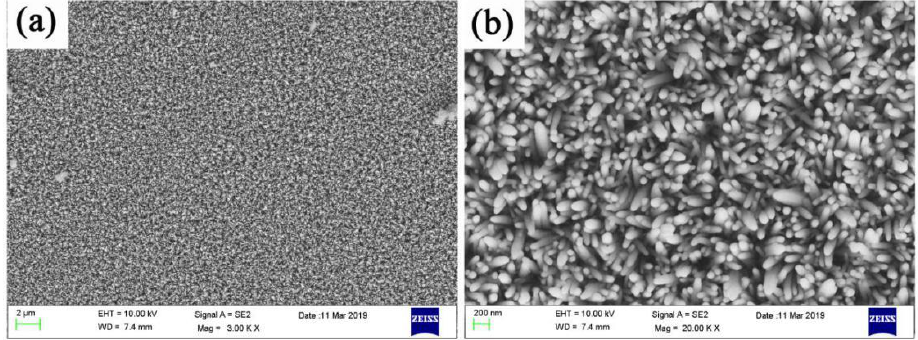
Figure 2. SEM image of Ag sputtered on the surface of ZnO nanorods at low magnification ( a ) and high magnification ( b ) viewing angles, corresponding to sample 5#.